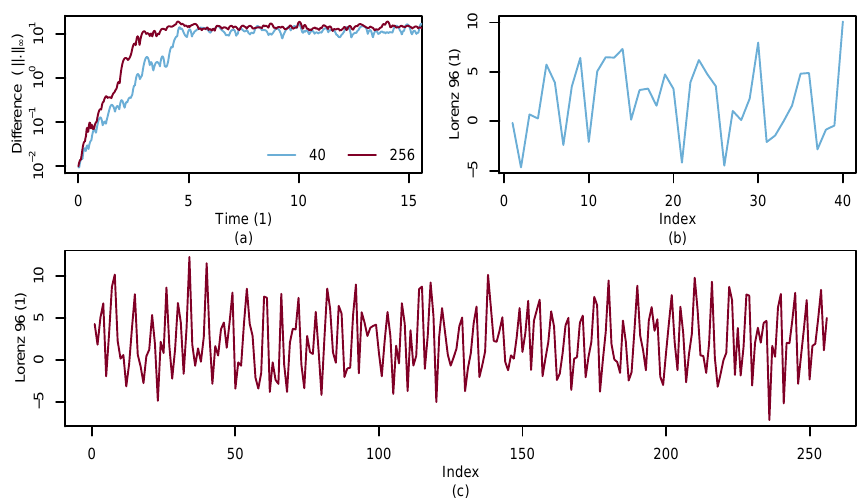
Figure 1. (a) Growth of the difference in the maximum norm |·| ∞ of two initially close solutions of the Lorenz 96 model. The initial states differ by white noise with variance of 10 − 4 . The growth of the difference is shown for the state dimensions of 40 and for the state dimension 256. (b) A solution of the Lorenz 96 model with state dimension 40 after 50 time units. (c) A solution of the Lorenz 96 model with state dimension 256 after 50 time units.